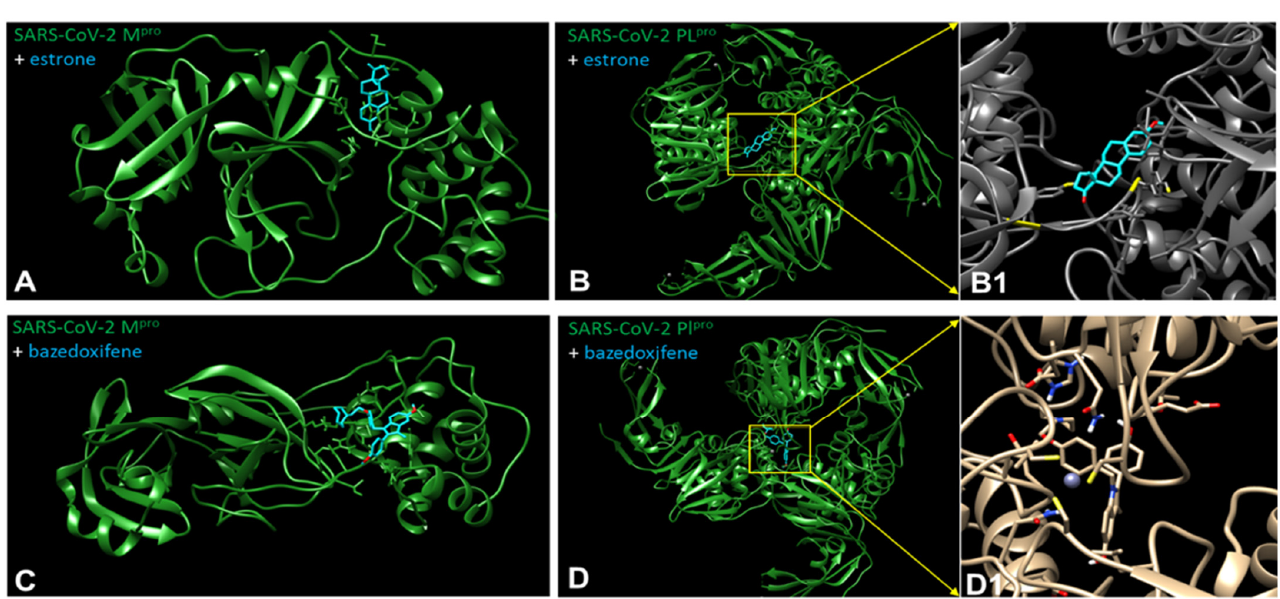
Figure 4. The best docking pose of estrone (above) and bazedoxifene (below) to the SARS − CoV − 2 main protease structure (M pro ) ( A , C ) and papain-like protease (PL pro ) trimer ( B , B1 , D , D1 ). Pymol representation of the SARS − CoV − 2 main protease (PDB id 6y7b) shown as a green ribbon with the secondary structure elements indicated. In blue sticks: the best docking pose for estrone ( A ) or bazedoxifene ( C ). The best docking poses of the estrone ( B , B1 ) and bazedoxifene ( D , D1 ) molecule in PL pro trimer (PDB id 6w9c) are localized in the vicinity of the zinc ion present at the central interface of the trimer.